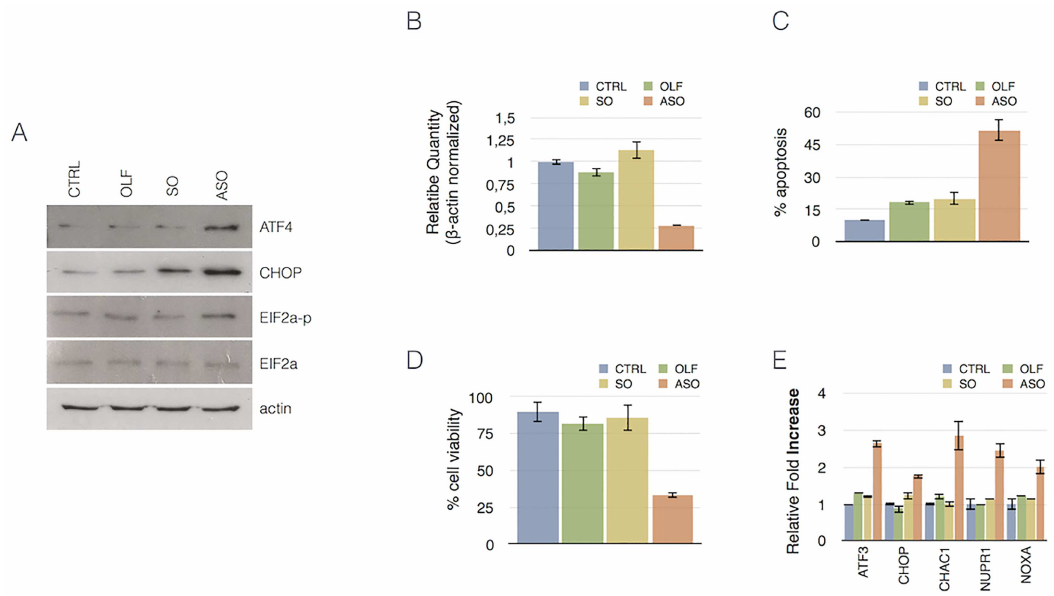
Fig 7. Western blotting demonstrating the significant increaseof ATF4, CHOP and EIF2a-p after CSB knockdown. B) Graphs showingqRT-PCR analysisof CSB mRNA expressionin SKNBE-2c cells, at 12h after the transfection. The results, normalized to β -actin, were averagedfrom values obtainedby performing three technicalreplicates.The values are means ± SD. Graphs showingapoptosis(C) and cell viability(D) percentagein SKNBE-2c cells 48h after CSB ablation. The results were averagedfrom values obtained by performingthree technical replicates. The values are means ± SD. E) Graphs show relativefold change values of up-regulation of selectedgenesin SKNBE-2c cells. The results, normalized to β -actin, were averaged from values obtainedby performingthree technicalreplicates. The values are means ±